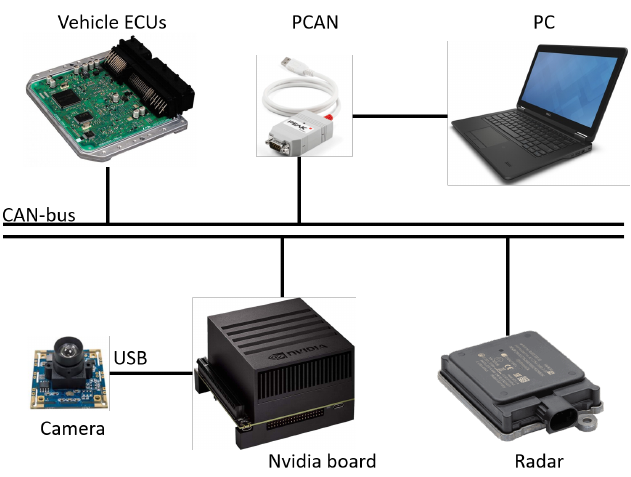
Figure 5. In-vehicle hardware architecture.